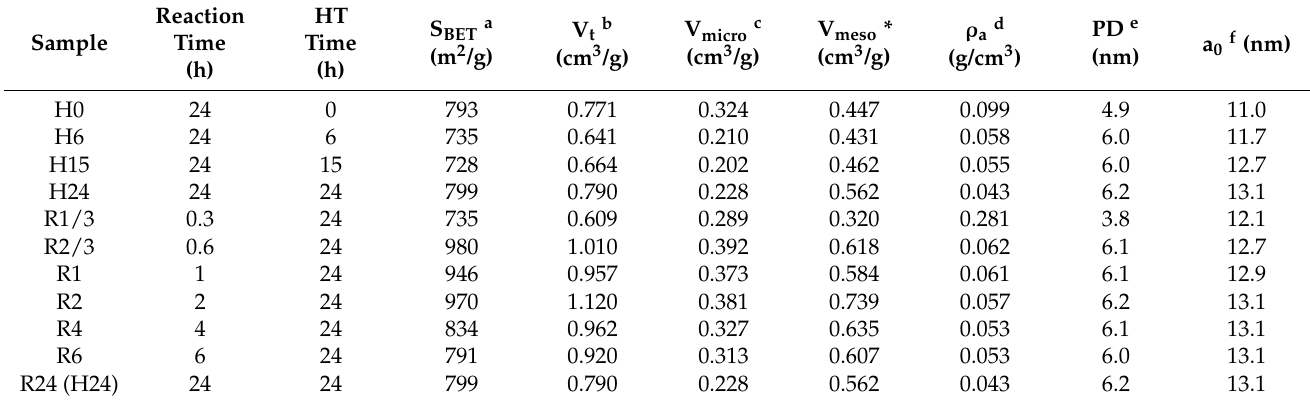
Table 1. Textural properties of the samples